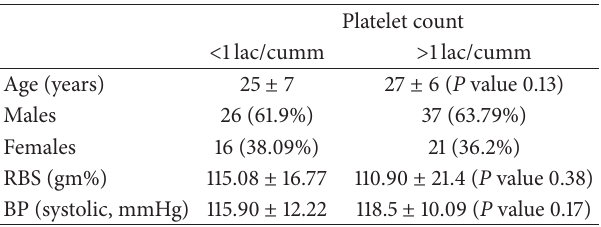
Table 2: Frequency of various symptoms and clinical features at presentation in the two